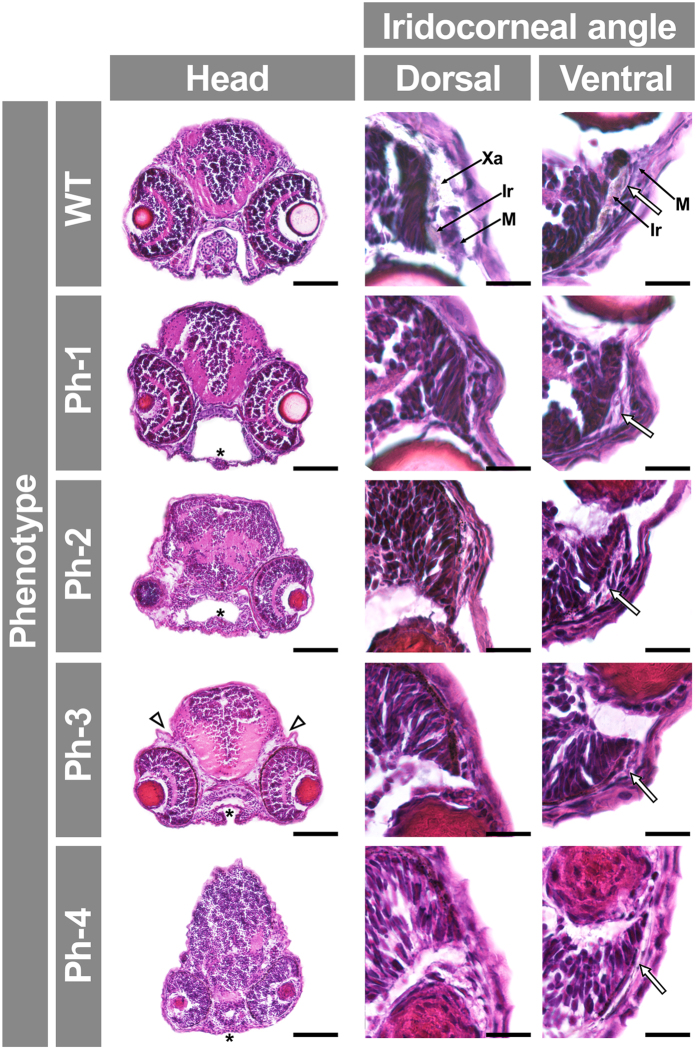
Analysis of gpatch3 knock-down-associated phenotypes in histological transverse sections of zebrafish gpatch3 morphants.Gpatch3ATG MO-injected zebrafish embryos were analyzed at 96 hpf and four phenotypes (Ph-1-4) with increasing severity were described. The 100X and 400X brightfield micrographs of 10 μm cryostat transverse head sections stained with hematoxilin and eosin show altered phenotypes including microphthalmia, mandibular maldevelopment (asterisks), enlarged intracranial and periocular spaces (empty arrowheads) and iridocorneal angle defects (empty arrows). Scale bars represent 100 μm in head section panels and 20 μm in iridocorneal angle magnification panels. Xa: xantophores. Ir: iridophores. M: periocular mesenchyme.